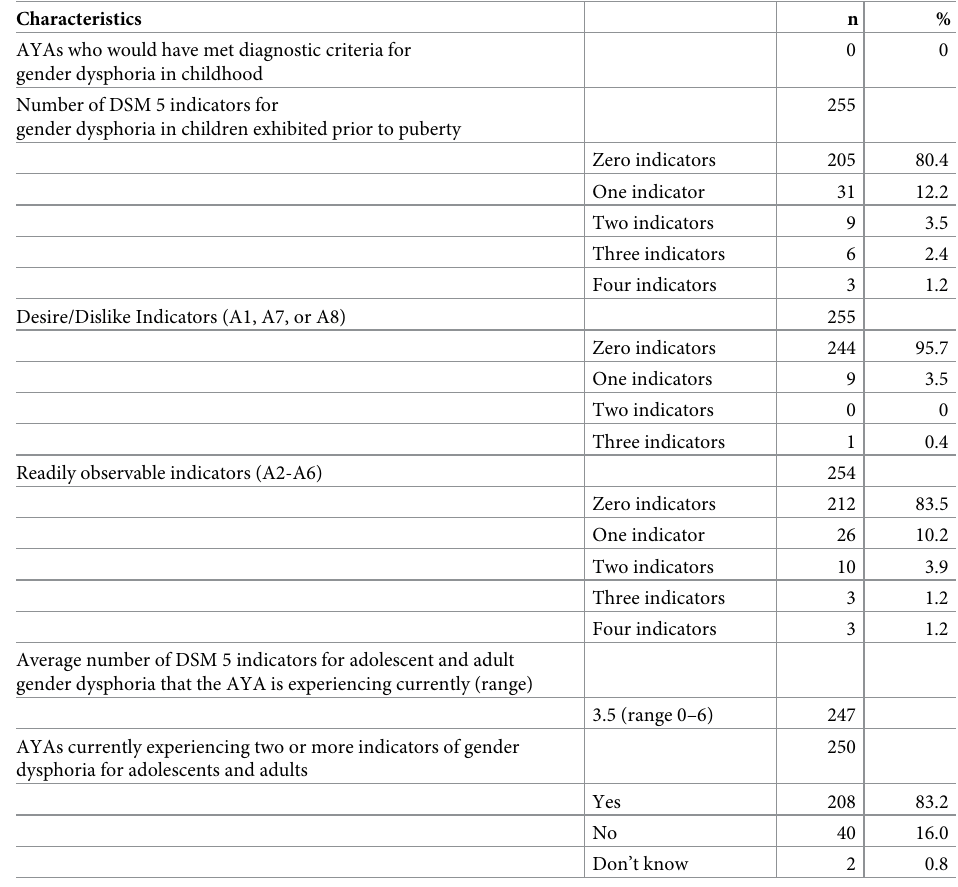
Table 3. DSM 5 Indicators for gender dysphoria.